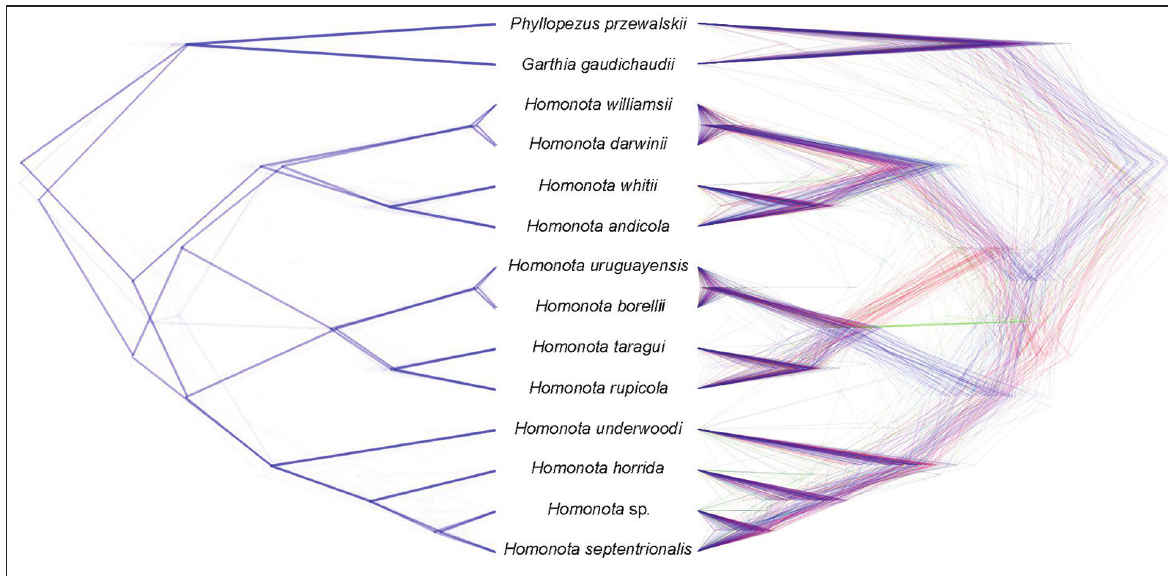
Figure 1. Species tree (left) and density of trees (right) for the species of the genus Homonota , based on the genes 16S, Cytb, and PRLR. The intensity in the color of the species tree is proportional to the probability. Table 2. Normality Shapiro-Wilk ( W ) values for metric (above) and meristic (below) characters showing the p value. Values shaded in gray did not reach normality. See Methods section for reference to the acronyms.